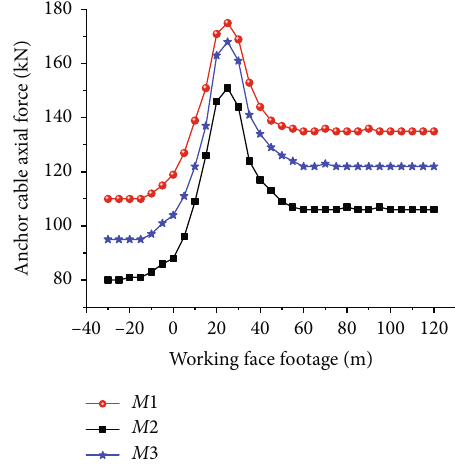
Figure 15: Variation law of roof anchor cable axial force.